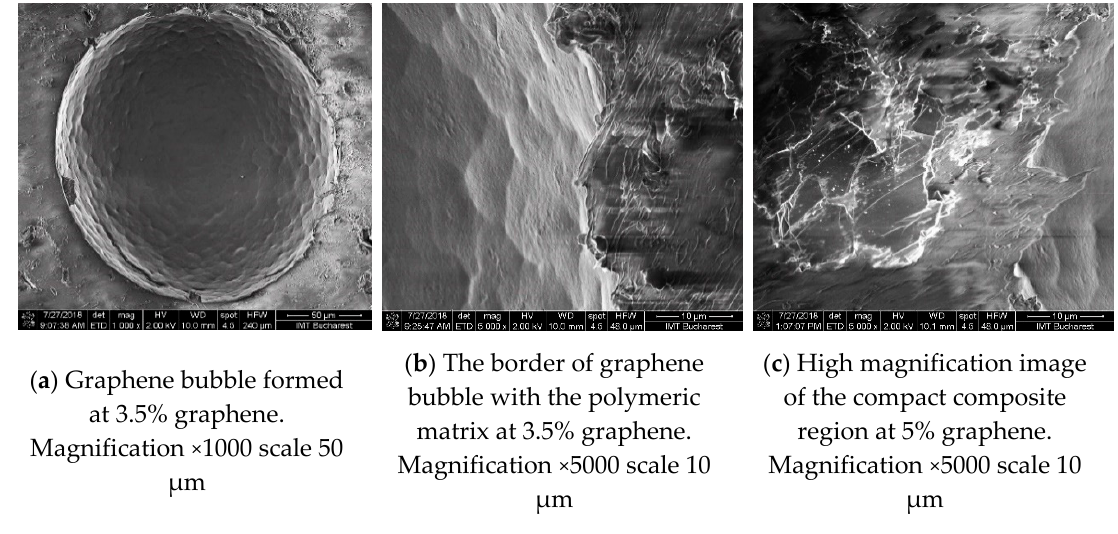
Figure 1. SEM images of samples fabricated at lower concentrations, showing the evolution of materials morphology (×5000 magnification, scale 10 μ m).